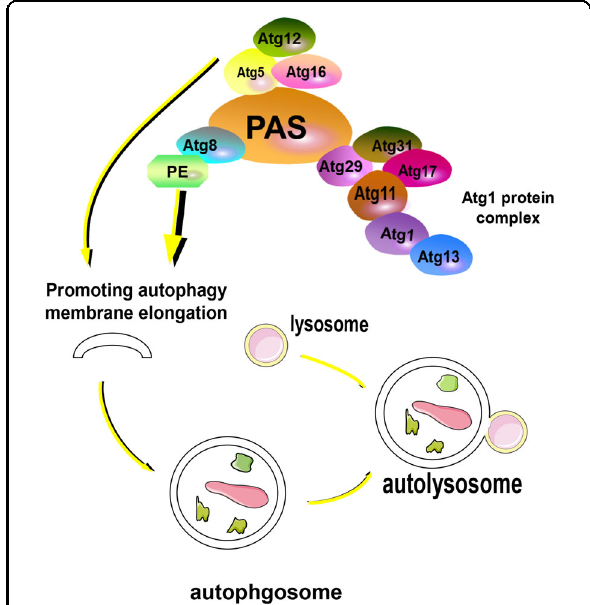
Fig. 2 Autophagosome integration in yeast cells. First, binding with Atg31 causes Atg29 to integrate into the Atg17 – Atg31 – Atg29 complex. Atg29 phosphorylation plays a key role in binding with other phosphoproteins. Moreover, Atg29 and Atg11 directly interact. Eventually, Atg1 combines with Atg13 and Atg11, with the latter directly associating with Atg17 and Atg19. In this way, the Atg1 protein complex takes shape. Moreover, the atg12 – atg5 – atg16 complex moves to the PAS and makes Atg8 combine with phosphatidylethanolamine (PE) to form the Atg8 – PE complex, which promotes the elongation of the autophagosome membrane and forms autophagosomes and